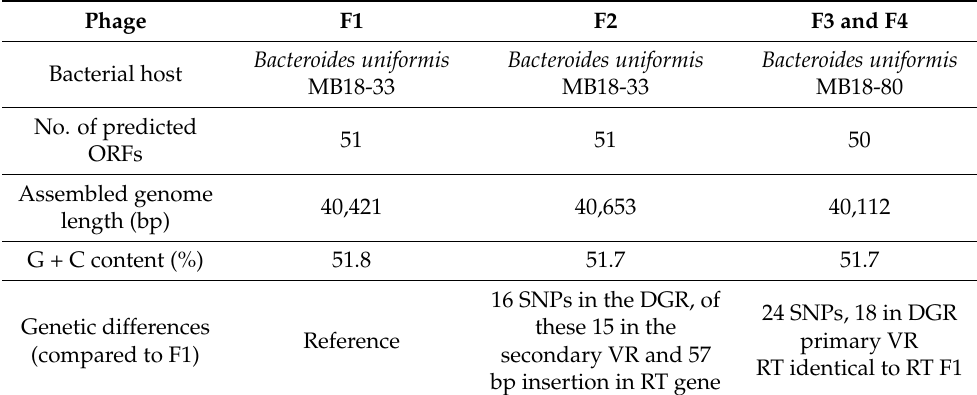
Table 1. Comparison of general characteristics of isolated phages belonging to a newly defined genus